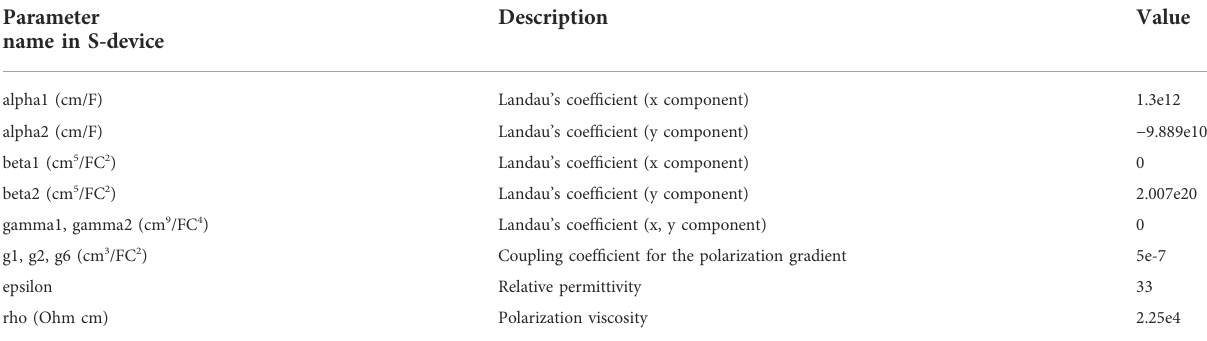
TABLE 1 Principle S-Device material parameters for the considered HZO ferroelectric layer.